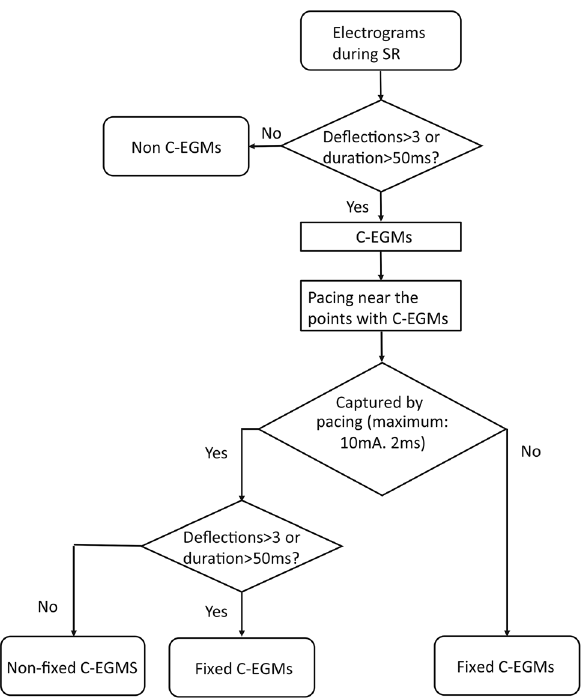
Figure 1. Identification of C-EGMs, fixed C-EGMs and non-fixed C-EGMs. SR, sinus rhythm; C-EGMs, complex electrograms in sinus rhythm.